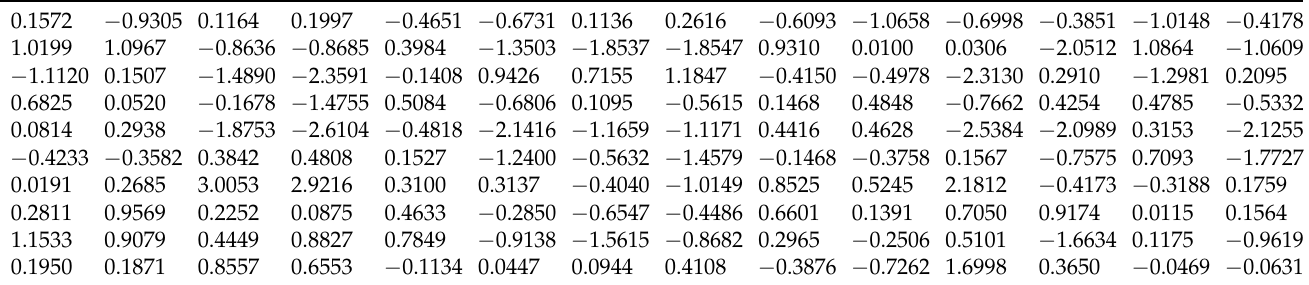
(cid:2) (cid:3) IW 1,1 ). 10 × 14